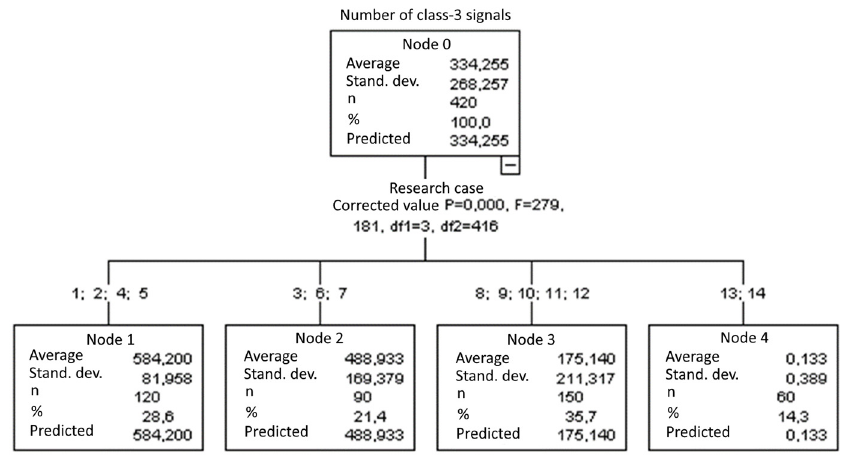
Figure 22. Classification tree for the number of class-3 signals.